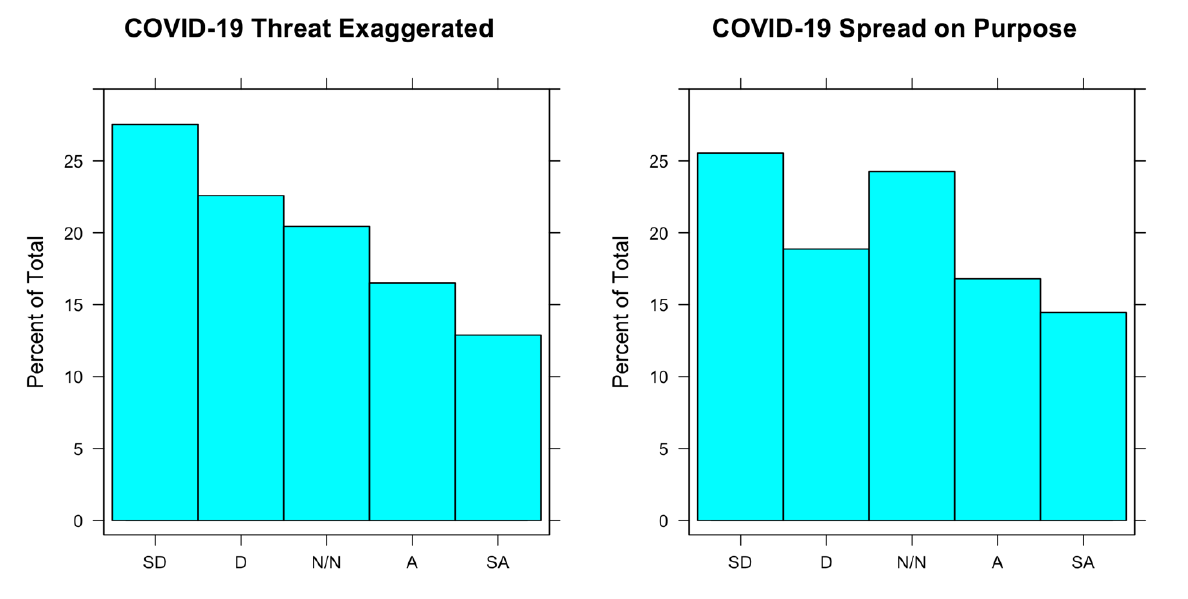
Figure 1. Distribution of beliefs that COVID-19 “threat is exaggerated” and was “spread on purpose”. “SA”=strongly agree, “N/N”=neither agree/nor disagree, “SD”=strongly disagree. The mean on the left panel is 1.65 on a 0–4 scale; mean on the right is